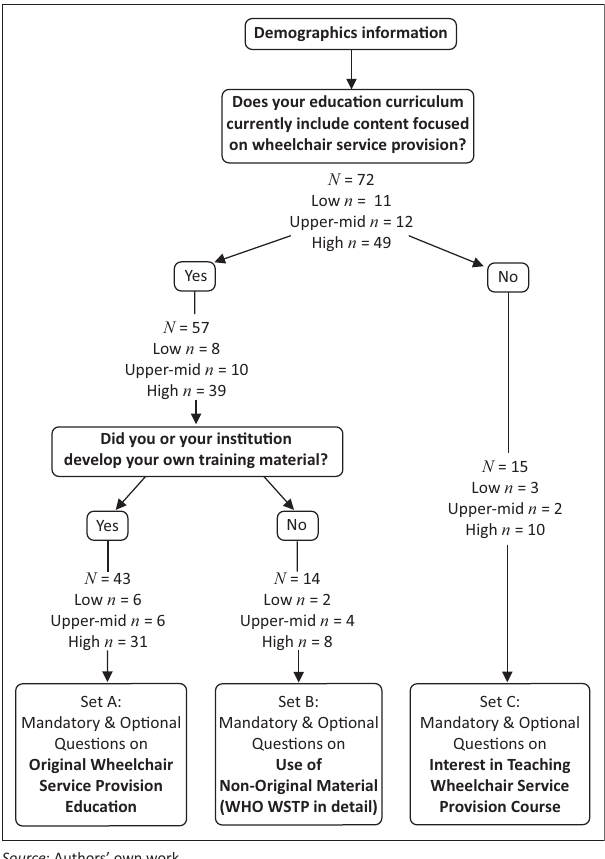
FIGURE 1: Flow chart of the survey pathway and the sample